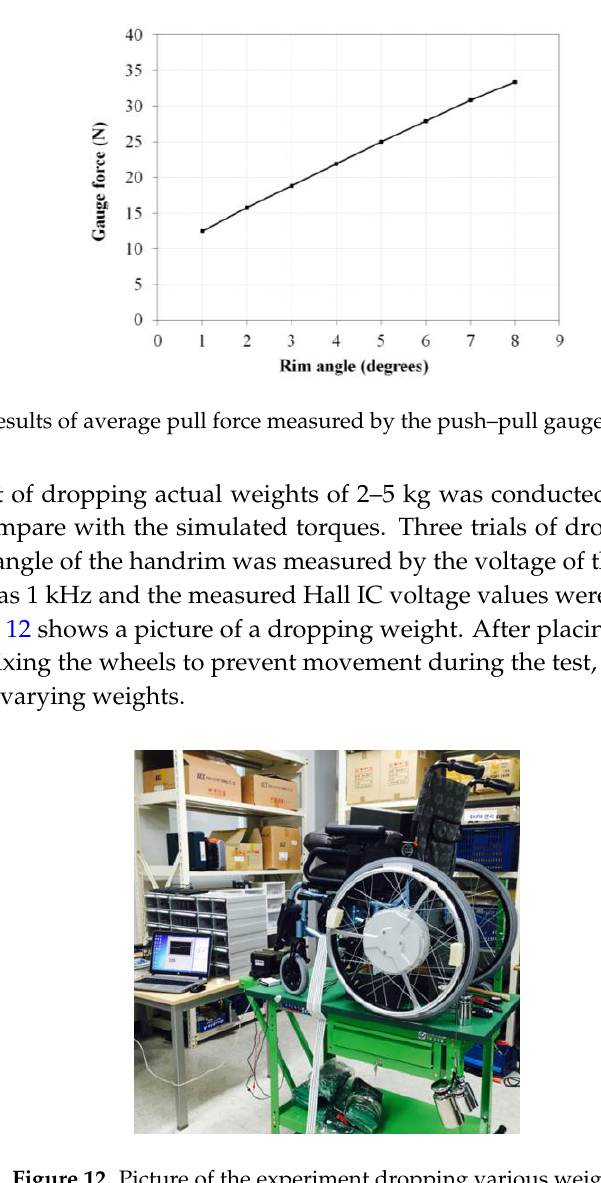
Figure 10. Results of average Hall sensor voltage measured at 1° increments.